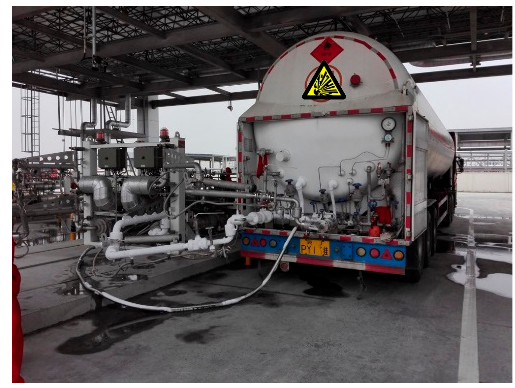
Figure 2. Tank car bottom